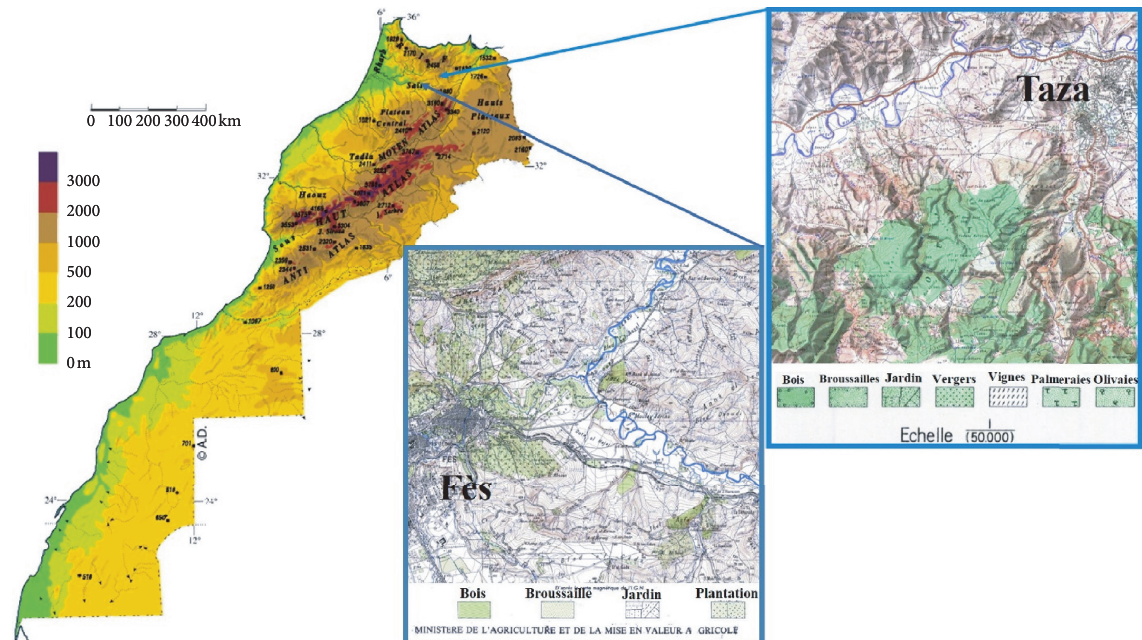
Figure 1: Geographical map of the origin of olive (taza) and sampling OMW (Fes),